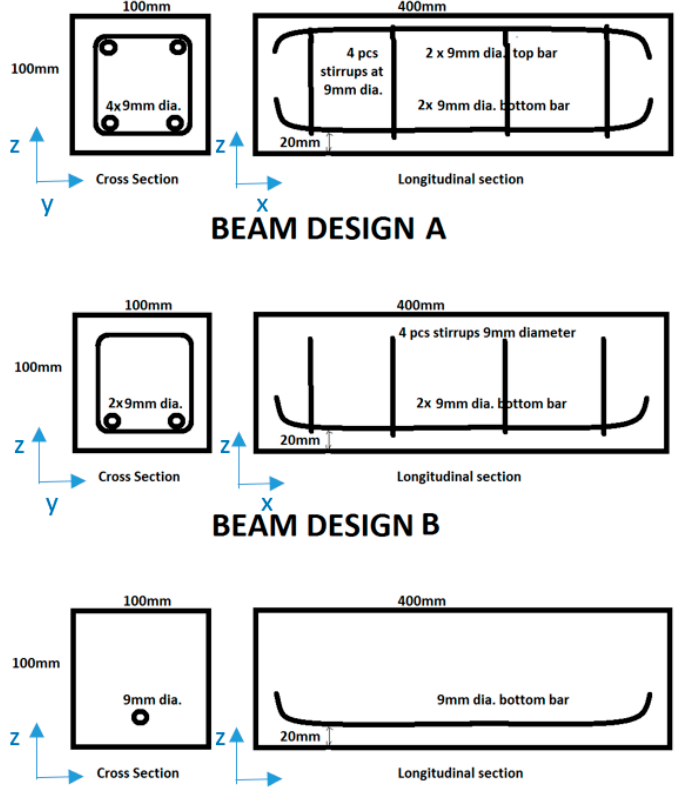
Figure 3. Reinforcements of the three beams (dimensions in mm) pc: pieces.